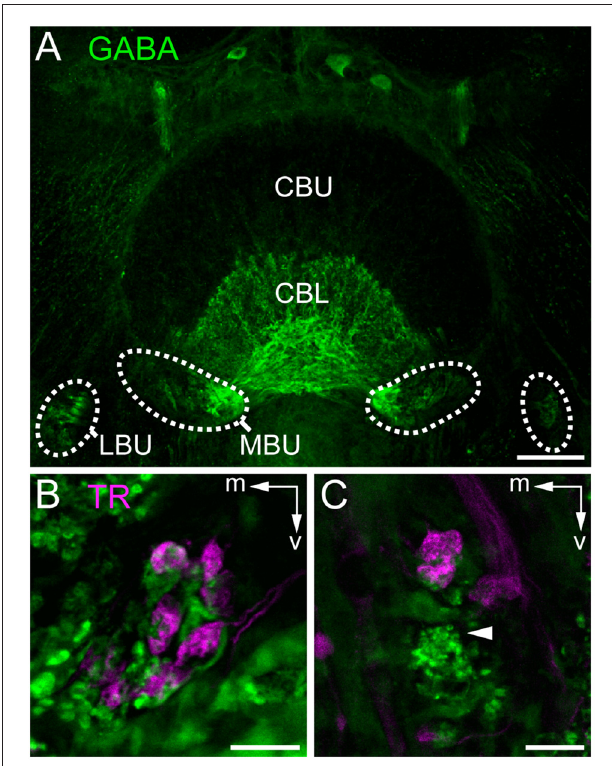
FIGURE 5 | Staining of neurons contributing to terminals in the bulbs. (A) Immunostaining for γ -aminobutyric acid (GABA; green) using the antibody from Abcam. GABA-immunoreactive TL neurons branch in the LBUs and the larger MBUs. The neurons have dense ramifications in the CBL whereas the upper division (CBU) is barely stained. (B,C) Double labeling by injection of dextran Texas Red into the AOTU, labeling TuLAL1 neurons (magenta) and immunostaining for GABA (green) with the antibody of Kingan, labeling TL neurons, reveals the structure of microglomerular synaptic complexes. (B) In the MBU TL3 neurons form complexes with large terminals of TuLAL1b neurons. The TuLAL1b neuron terminals are located on top of the TL neuron branches. (C) In the LBU the complexes have a similar structure. Here, GABA immunostaining exposes a bushy structure at the tip of the extension of a TL neuron (arrowhead). Scale bars: A = 50 µ m, B,C = 10 µ